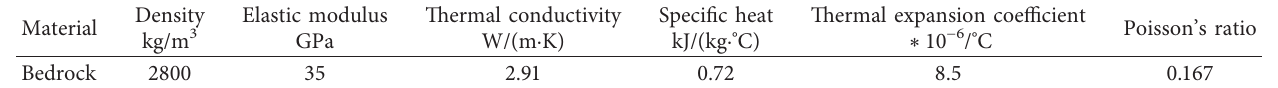
Table 1: Basic parameters of bedrock.